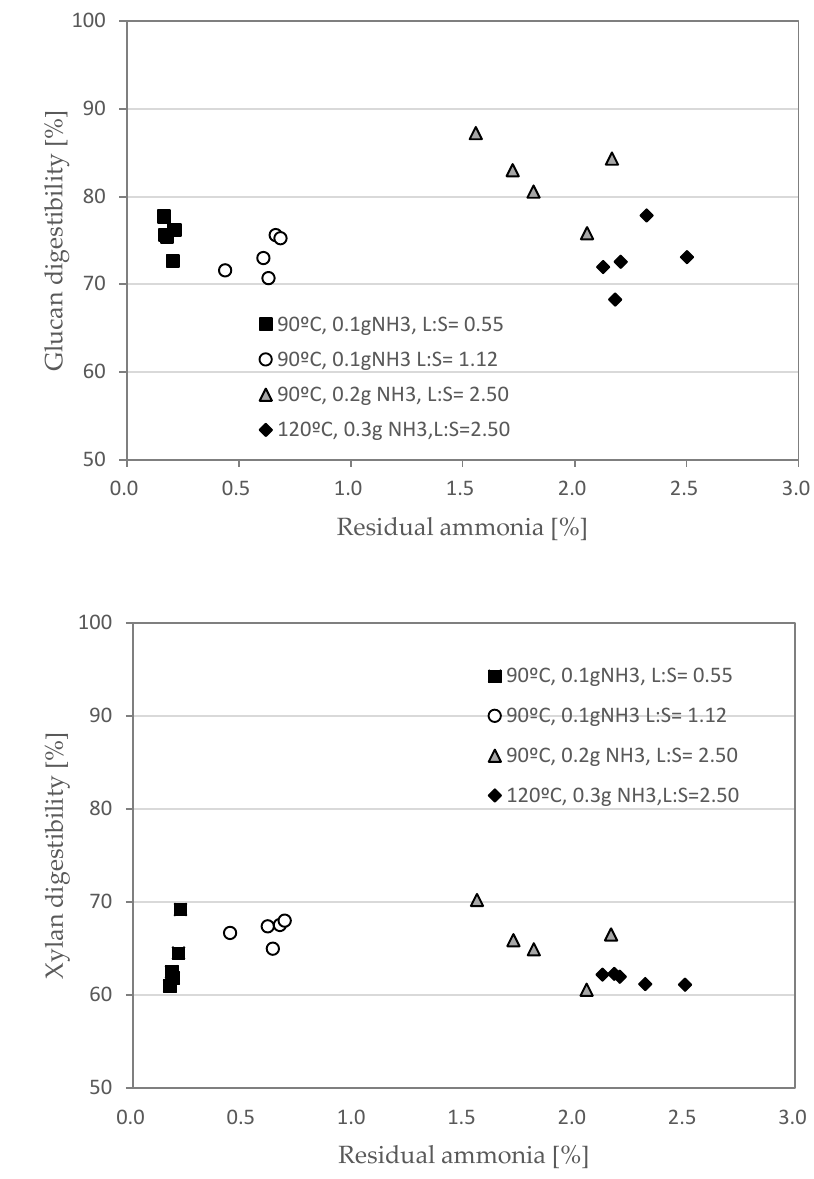
Figure 6. Effect of residual ammonia in ELLA-treated sample on ( a ) glucan digestibility and ( b ) xylan digestibility. ELLA conditions: L/S = 0.55–2.5; 0.1–0.3 g-NH 3 /g-biomass, 90–150 ◦ C, 24–120 h. Enzymatic hydrolysis conditions: CTech2; 15 FPU/g-glucan loading; 50 ◦ C; 150 rpm;